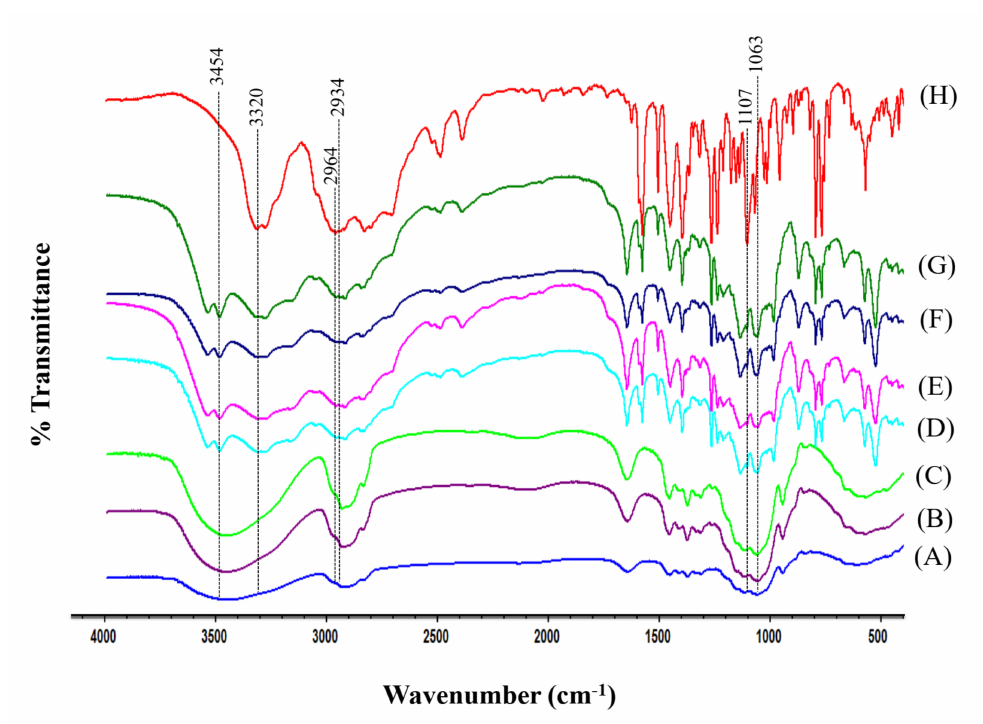
Figure 2. FT-IR spectra of H-K4M ( A ), H-K15M ( B ) H-K100M ( C ), Tab-K4M ( D ), Tab-K15M ( E ), Tab-K100M ( F ) Tab-Mixed ( G ), and PNL ( H ).